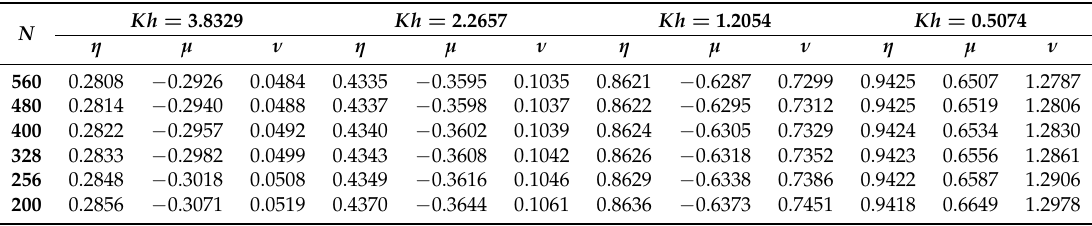
Table 1. Values of hydrodynamic efficiency η max , radiation susceptance coefficient µ and radiation conductance coefficient ν computed for different number of nodes N with h a / h = 0.125, b / h = 1.0 and w / b =